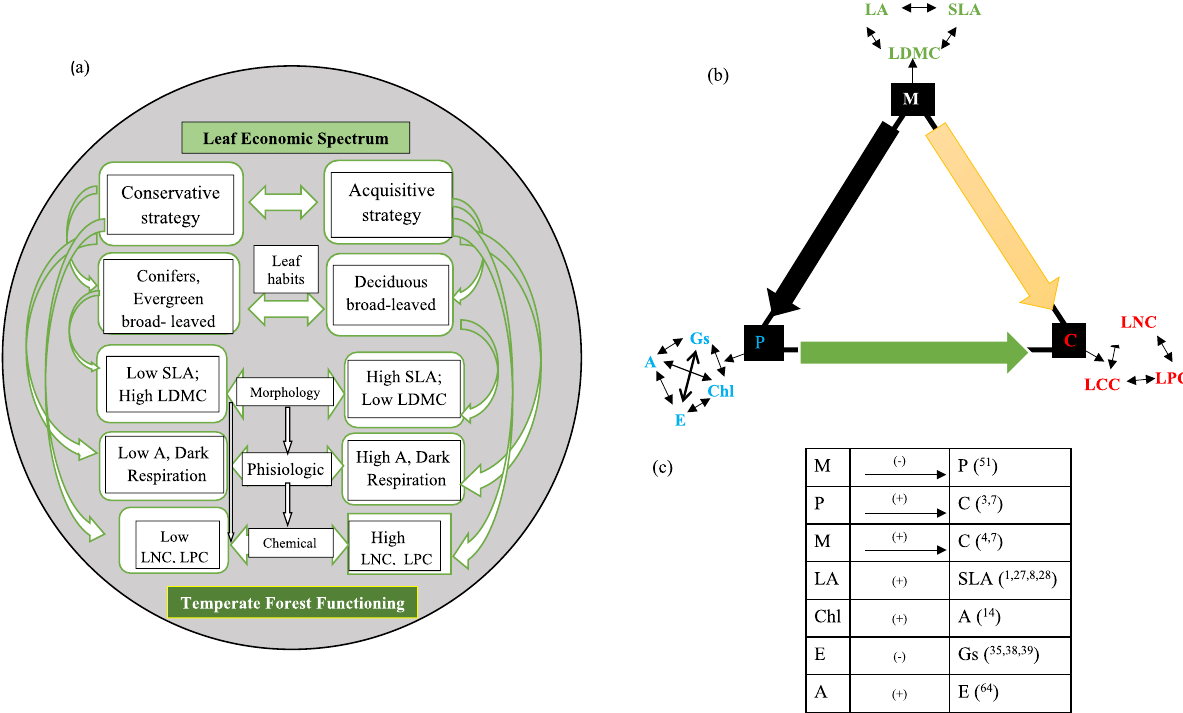
Figure 3. ( a ) Leaf economic spectrum of different leaf habits ( b ) Theoretical framework of the casual relationships among morphological, physiological, chemical and stochiometry traits (Symbols; M: Morphology, P: Physiology, C: Chemical) of temperate forest ecosystem and ( c ) evidences for relationship along with direction between traits (Some other proposed relationship was hypothesized to exist in temperate